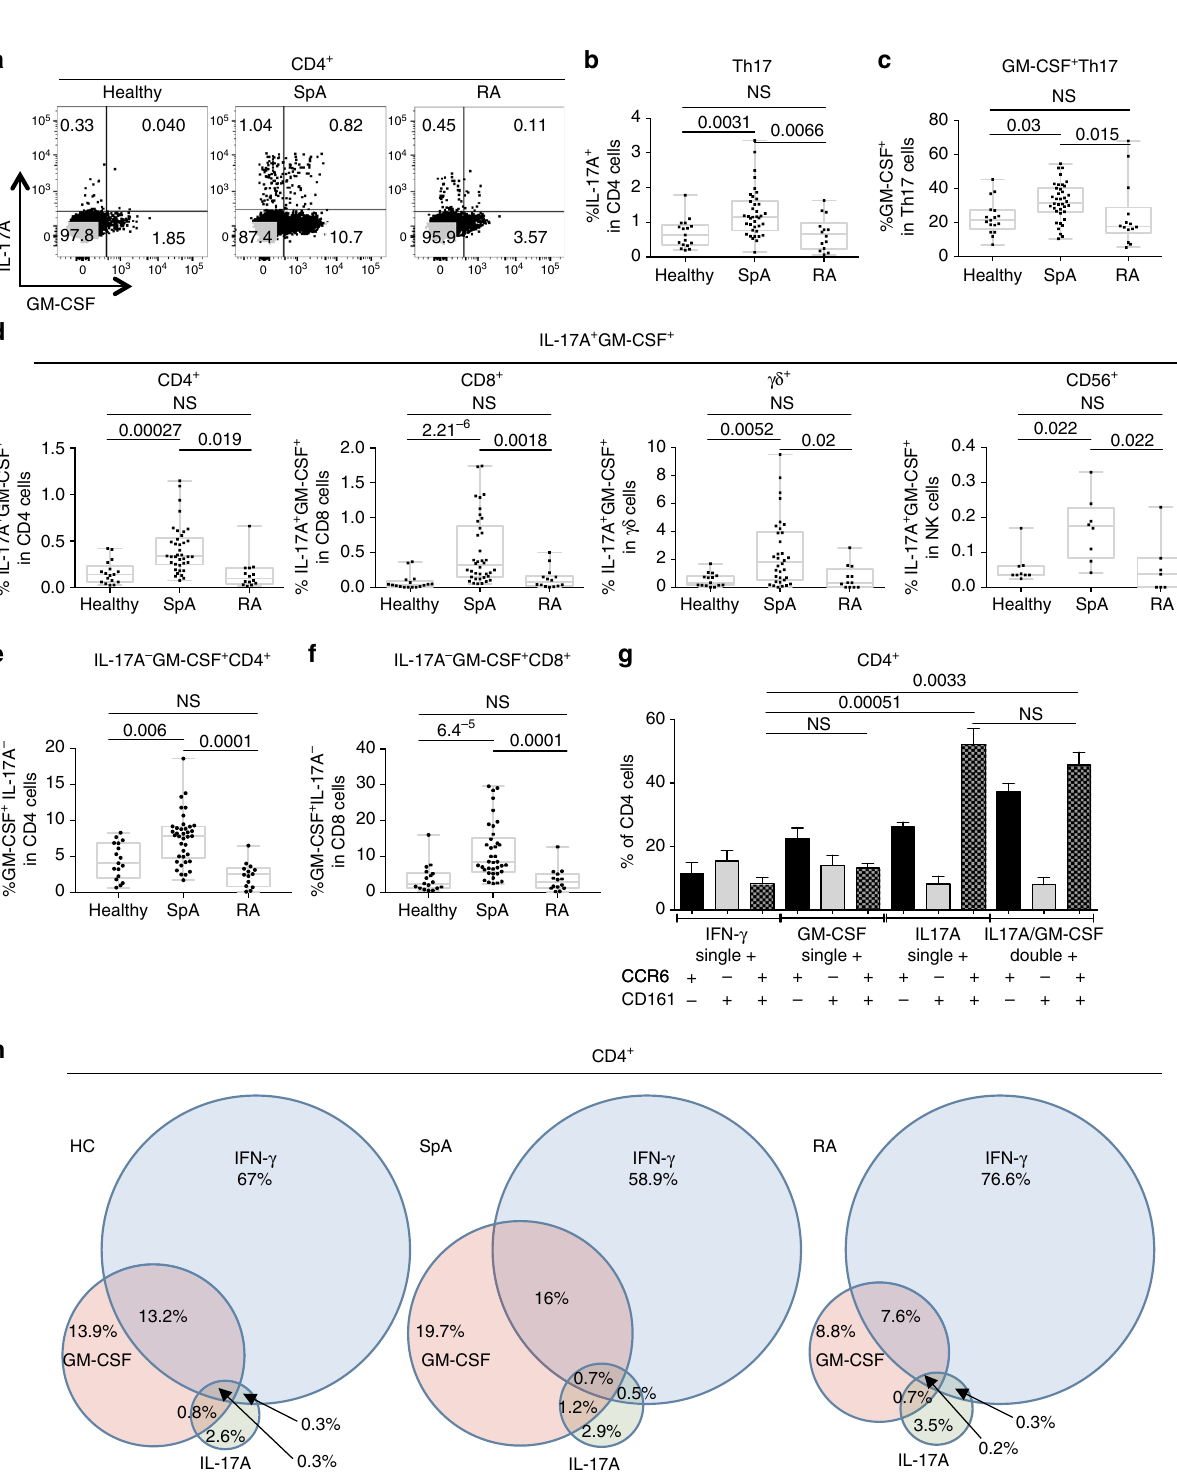
Fig. 1 GM-CSF + cells are expanded in multiple lymphoid populations in spondyloarthritis. a Representative fl ow cytometry plots comparing intracellular staining for IL-17A and GM-CSF in healthy, spondyloarthritis (SpA) and rheumatoid arthritis (RA) PBMCs (gated on live CD3 + CD4 + lymphocytes). b Total IL-17A + CD4 + cells (Th17) and c percentage of Th17 cells also expressing GM-CSF for healthy ( n = 17) SpA ( n = 38) and RA ( n = 14). d Percentage of IL-17A + GM-CSF + cells within the CD4 + , CD8 + , γδ + and CD56 + gates in the same cohort of patients and controls. Percentage of GM-CSF + CD4 e and CD8 f independently of IL-17A in the cohort of patients and controls. g CD161 and CCR6 expression was measured by fl ow cytometry on single positive IL- 17A + , IFN- γ + , GM-CSF + and IL-17A + GM-CSF + double-positive CD4 cells ( n = 8; mean + SEM shown, Friedman ’ s test). h Venn diagram of mean PBMC cytokine data from healthy donors, SpA and RA patients derived by Boolean gating, the percentage of each cytokine is represented in relation to the total number of cytokine-producing CD4 T cells. All statistical analysis (except g , Friedman ’ s) determined by Kruskal – Wallis test with p -values calculated